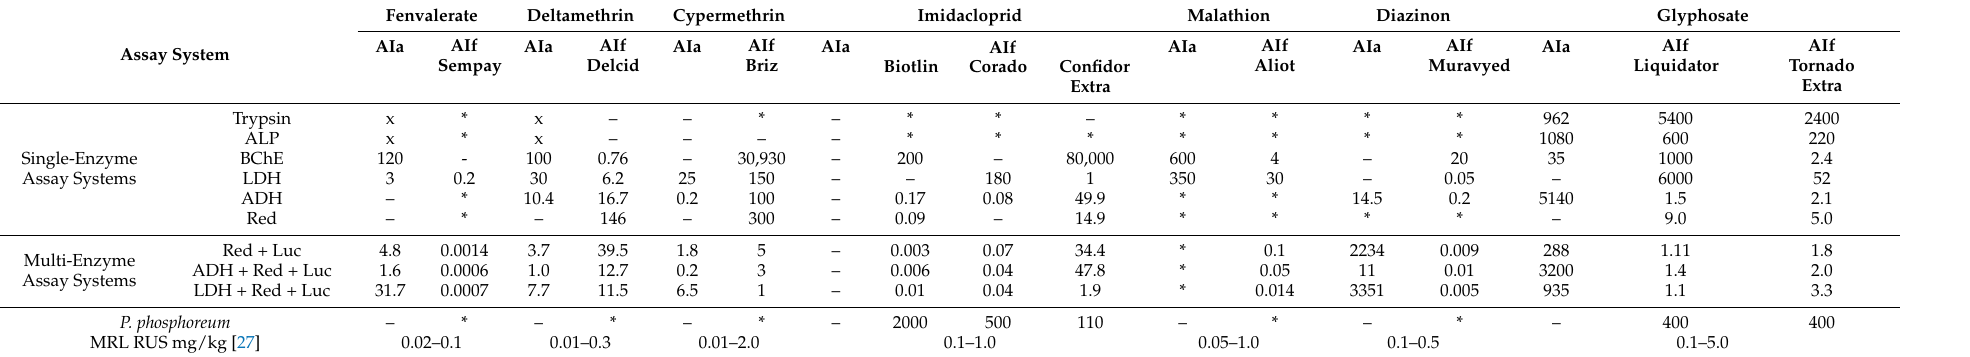
Table 1. IC 50 (mg/L) and EC 50 (mg/L) values determined from the effects of AIas and AIfs on the activities of enzyme-based assay systems and P. phosphoreum